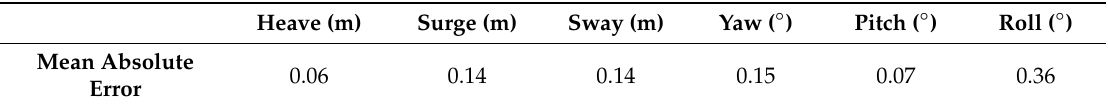
Table 10. Mean absolute error (MAE) for each of the six degrees of freedom analyzed using transfer functions. Heave (m) Surge (m) Sway (m) Yaw ( ◦